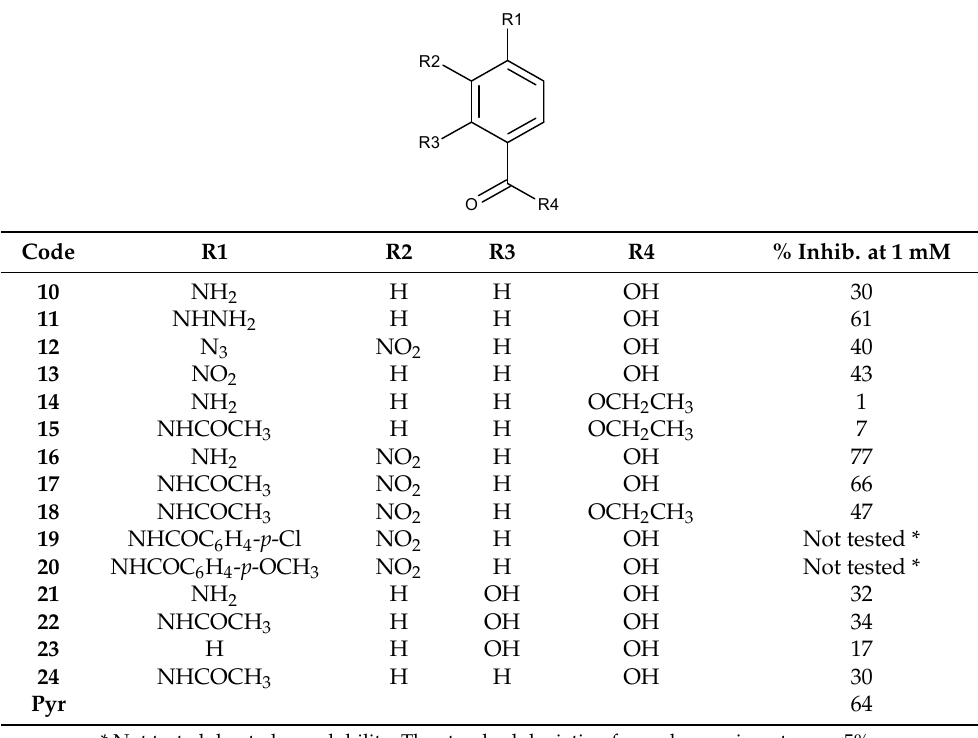
Table 2. TcTS inhibition values of benzoic acid derivatives.